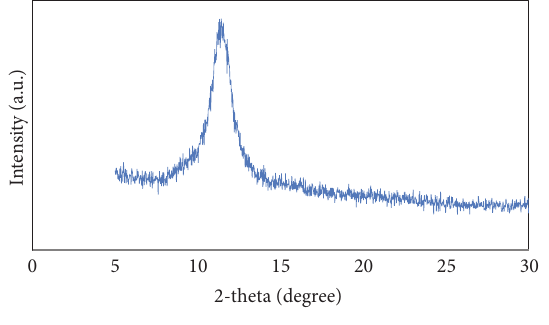
Figure 2: XRD spectra of GO powder.